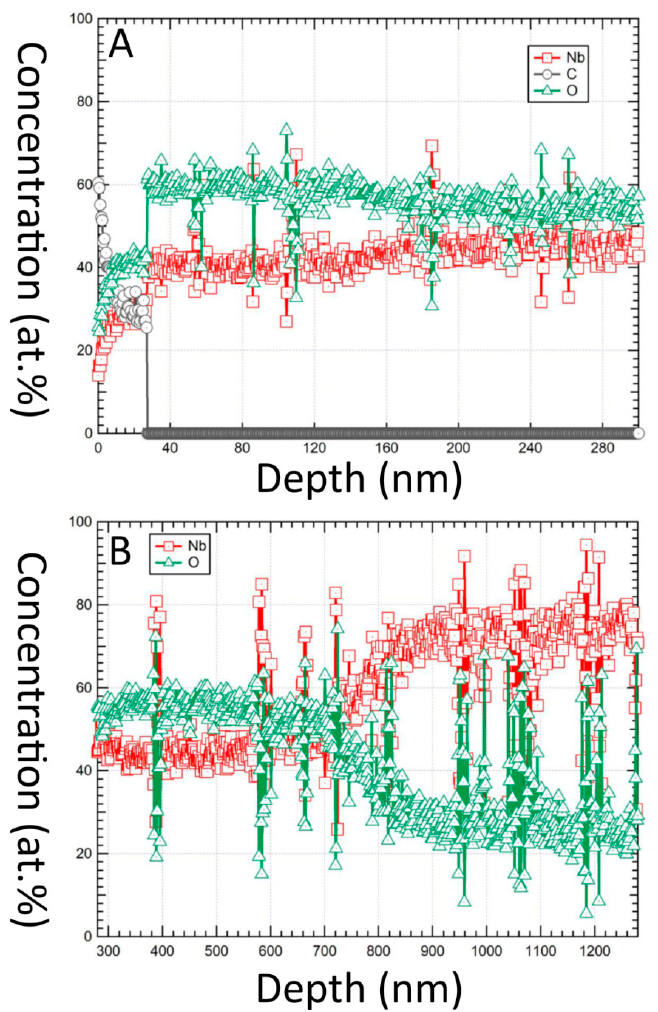
Figure 6. Compositional depth profiles of the Procodile sample, obtained by Auger electron spectroscopy (AES) coupled to Ar + ion bombardment. Profile in the near-surface region ( A ) and at depth ≥ 300 nm ( B ).